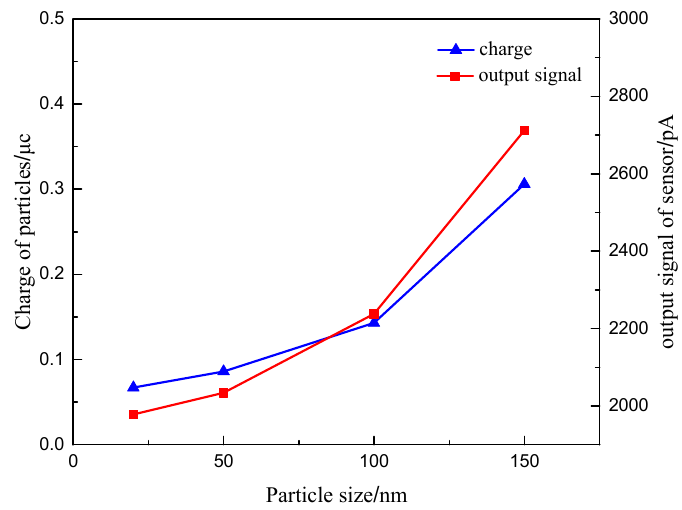
Figure 15. The law of charge of particles and output signal of sensor changing with different particle sizes.